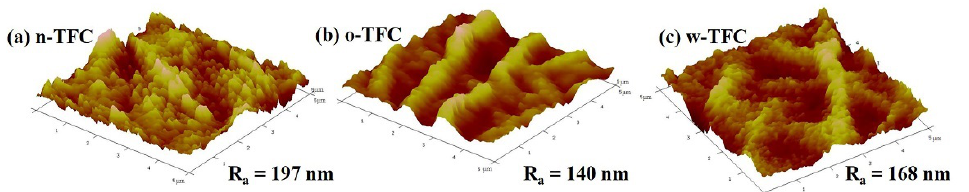
Figure 3. Atomic force microscopy (AFM) images of the nanofiber-supported TFC FO membranes prepared via different heat-curing methods. Table 1. Surface roughnesses of the polyamide (PA) active layers of the TFC FO membranes pre- pared via different heat-curing methods.